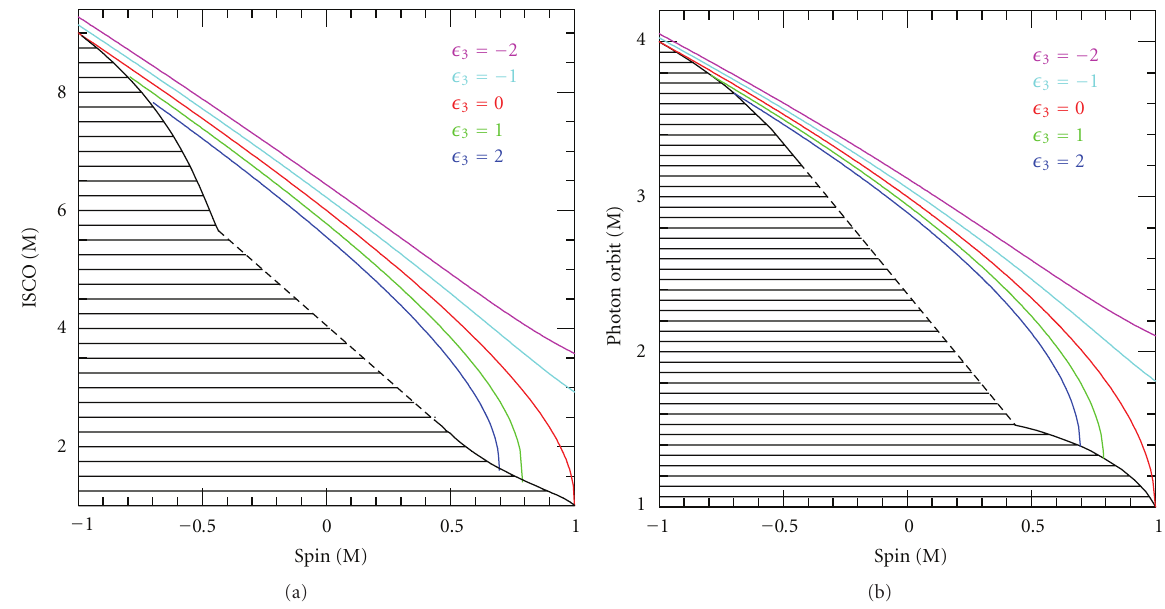
Figure 2: Radius of (a) the ISCO and of (b) the circular photon orbit as a function of the spin a for several values of the parameter (cid:2) 3 . The radius of the ISCO and the circular photon orbit decrease with increasing values of the parameter (cid:2) 3 . The shaded region marks the excluded part of the parameter space [34].